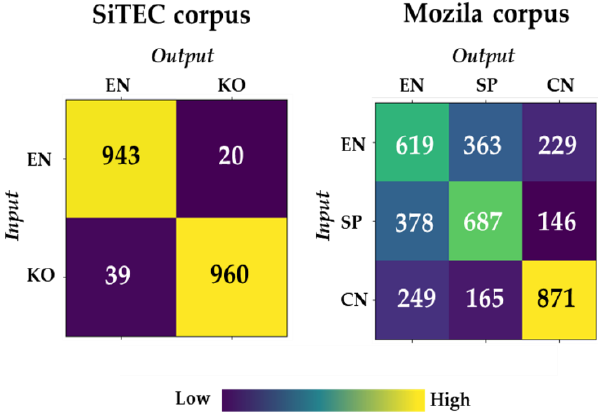
Figure 10. LID performance of the proposed R-vector-based approach in terms of confusion matrix.